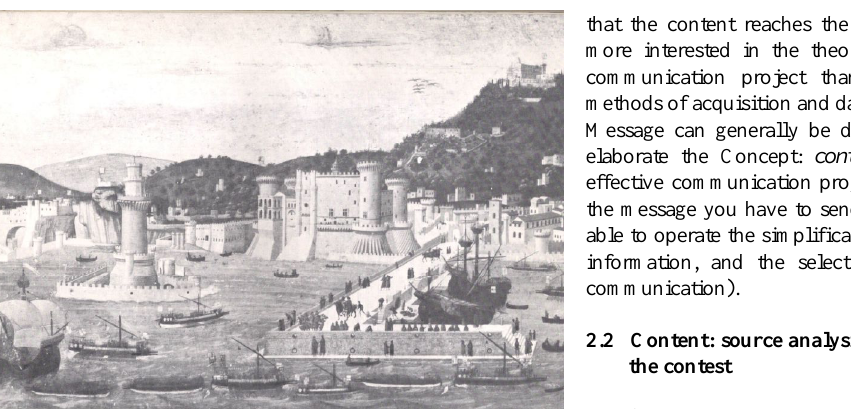
Figure 6: Strozzi 1464. The study of iconographic sources is very important to define a communication strategy